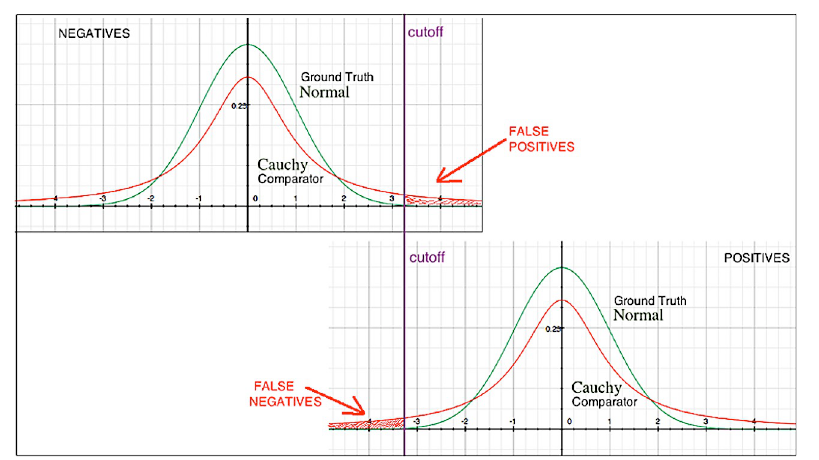
Fig 1. Example illustrating the problem of noise in a